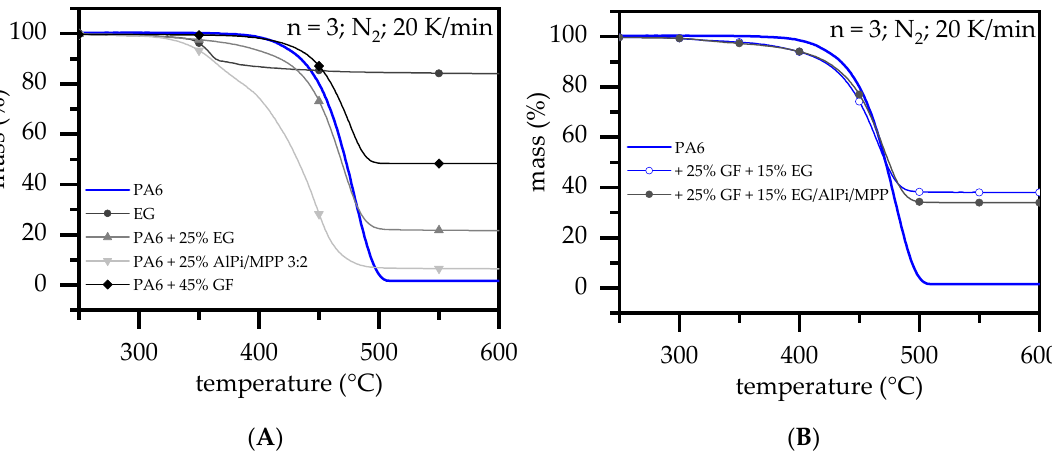
Figure 2. TGA analysis for a selection of formulations measured in a nitrogen atmosphere. ( A ) basic materials ( B ) multi-material formulations. Table 1. TGA and DSC measurement results summary.